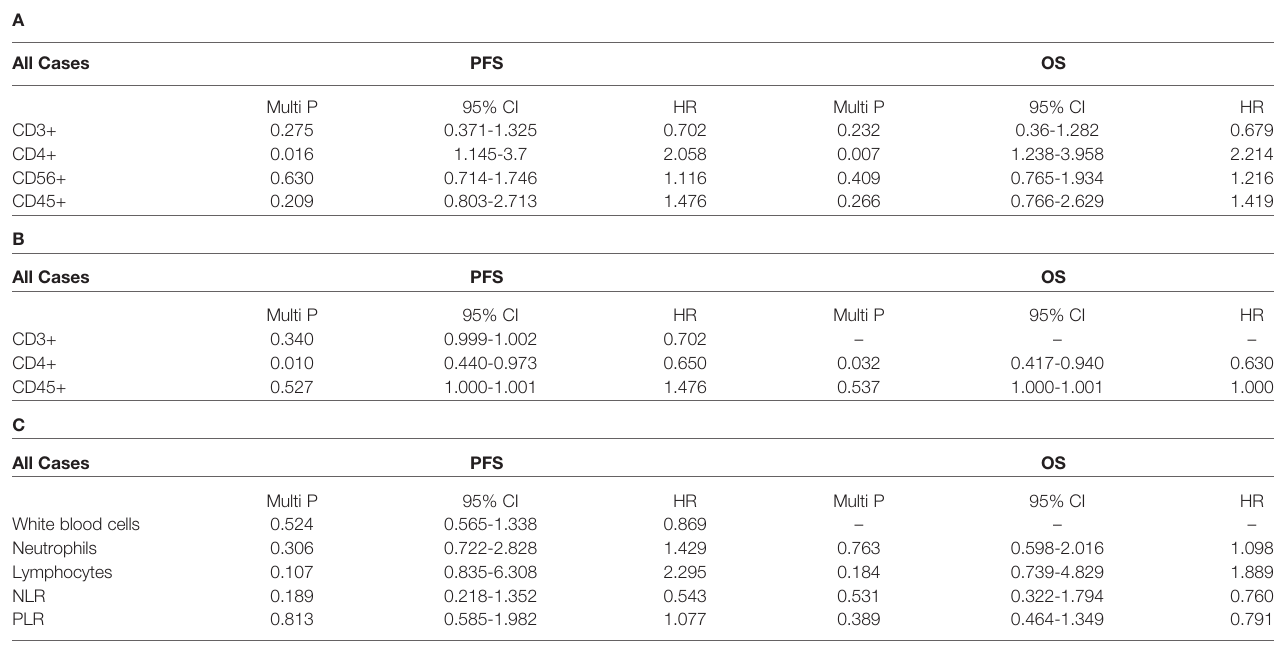
TABLE 3 | Multivariate prognostic value of circulating lymphocytes in TNBC for PFS and OS (A) , and multivariate prognostic value of circulating lymphocytes in mTNBC for PFS and OS (B) . Multivariate prognostic value of blood routine index, NLR, and PLR in TNBC for PFS and OS (C)